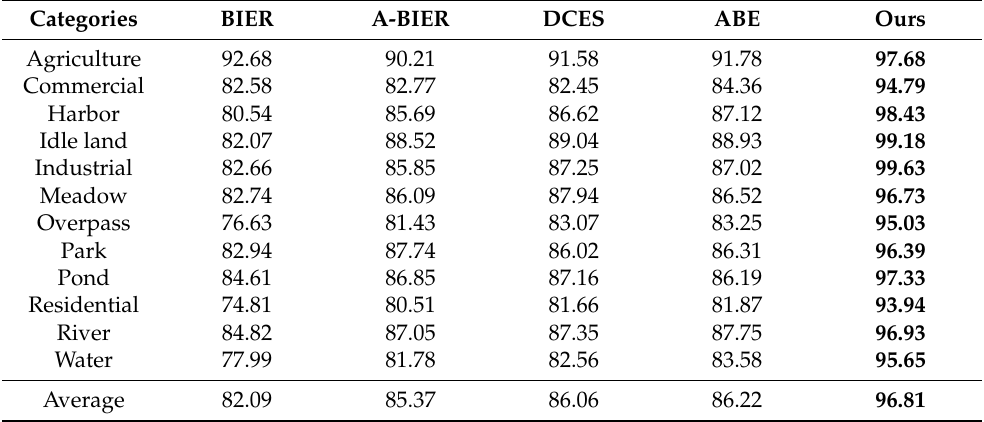
Table 6. mAP (%) of 12 geographic categories in SIRI-WHU with various RSIR methods.